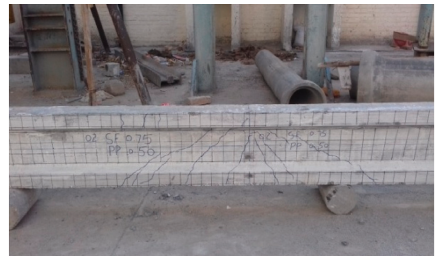
Figure 18: Crack patterns of B4-PPFRC-2.